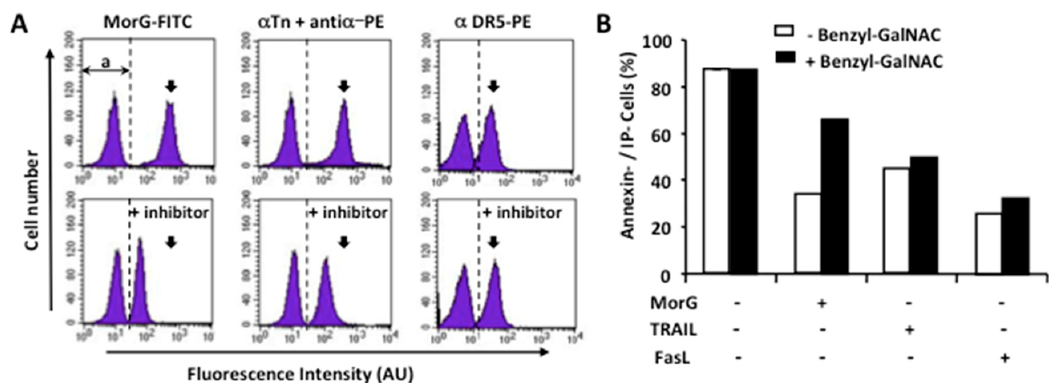
Figure 5. Morniga-G-induced cell death depends on O -glycosylation. Jurkat A3 leukemic cells were cultured with or without benzyl-GalNAc (8 mM), an O -glycosylation inhibitor. Subsequently, the cells were analyzed: ( A ) using cytofluorometry after staining with FITC-conjugated MorG (MorG-FITC), anti-Tn mouse monoclonal antibody + Phycoerythrin PE-conjugated anti-mouse antibody ( α Tn + anti α -PE) or PE-conjugated anti-DR5 monoclonal antibody ( α DR5-PE). Histograms overlay, a : auto-fluorescence histogram of Jurkat cells without staining on the left of vertical dotted line and stained cell histogram on the right, black arrow: mean fluorescence after staining and without inhibitor-treatment, representative of three independent experiments; ( B ) cytofluorometry after annexin/IP staining. Cell viability is shown as percentage of annexin- and IP-negative cells after a 24 h culture in presence of MorG (20 μ g/mL), TRAIL (50 ng/mL), or FasL (50 ng/mL). Mean of two independent experiments.